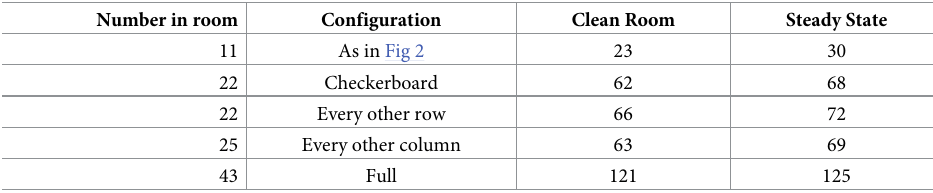
Table 2. Relative risks with different seating